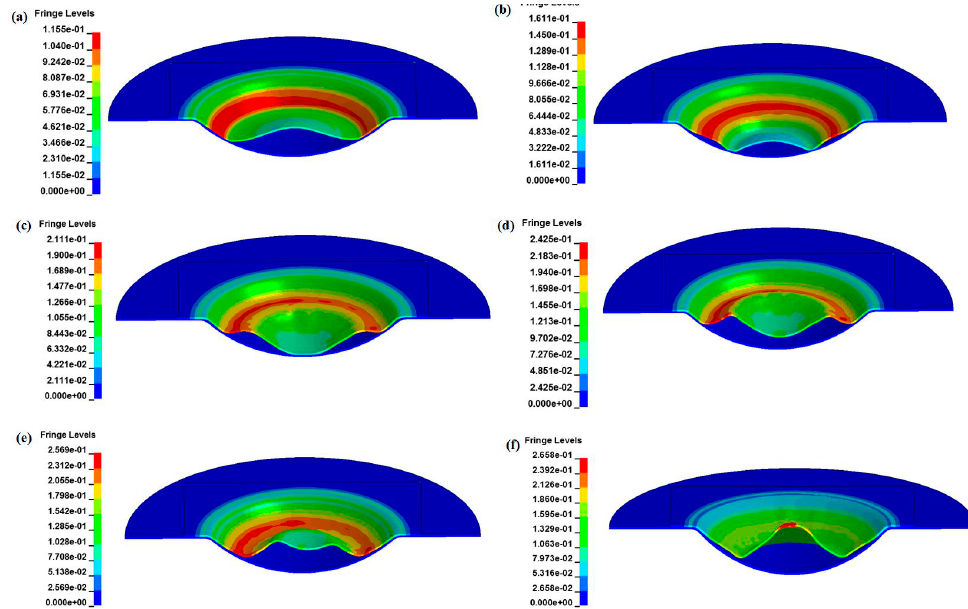
Figure 20. The fracture process of 5052-O aluminum alloy electromagnetic under impaction forming with the die at a discharge voltage of 13.5 kV, after: ( a ) 80 μ s; ( b ) 120 μ s; ( c ) 160 μ s; ( d ) 200 μ s; ( e ) 250 μ s; and ( f ) 300 μ s.